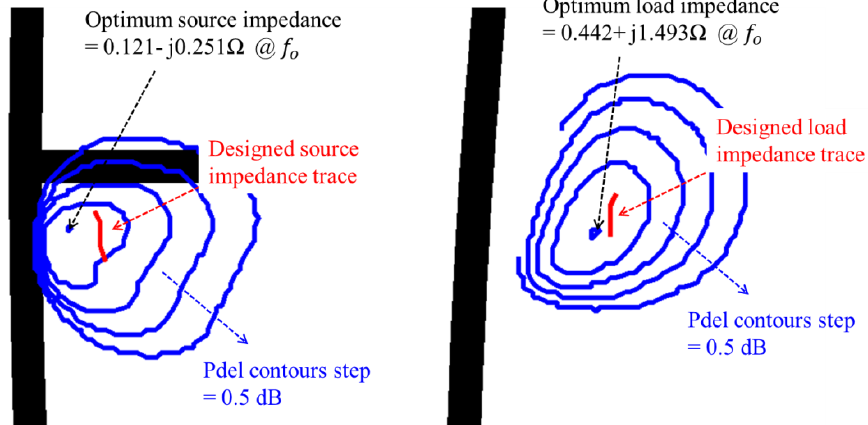
Figure 6. Designed source and load impedance traces overlapped on the simulated source-pull and load-pull contour plots.